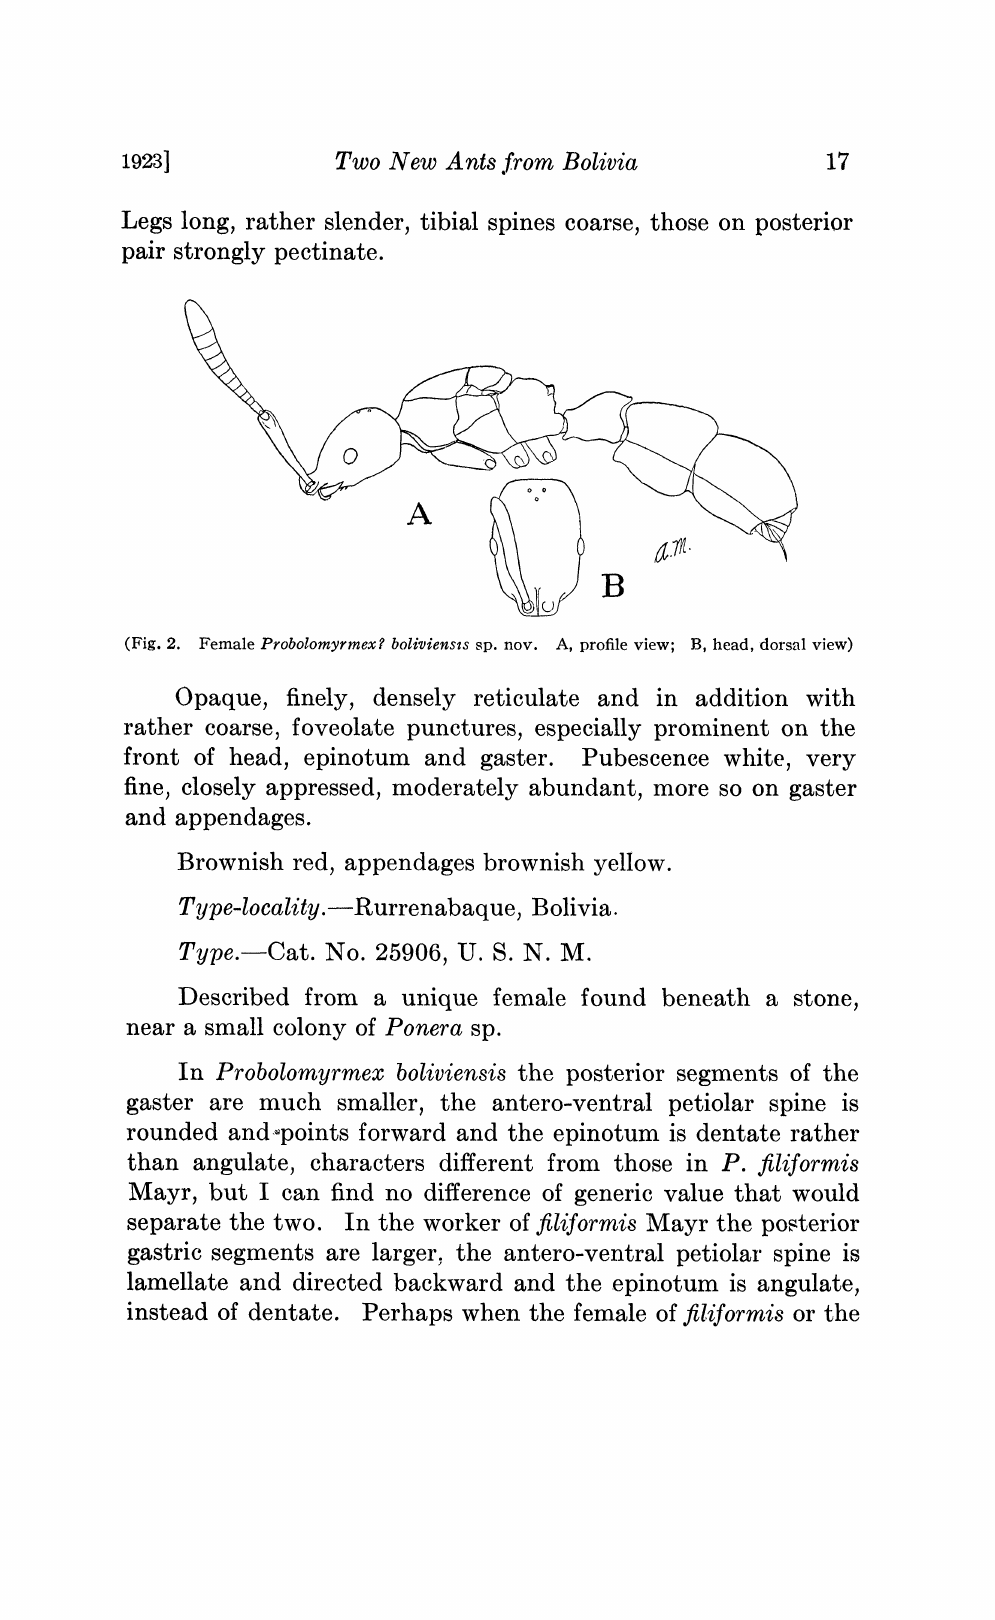
(Fig. 2. Female Probolomyrmex? boliviens,s sp. nov. A, profile view; B, head, dorsal